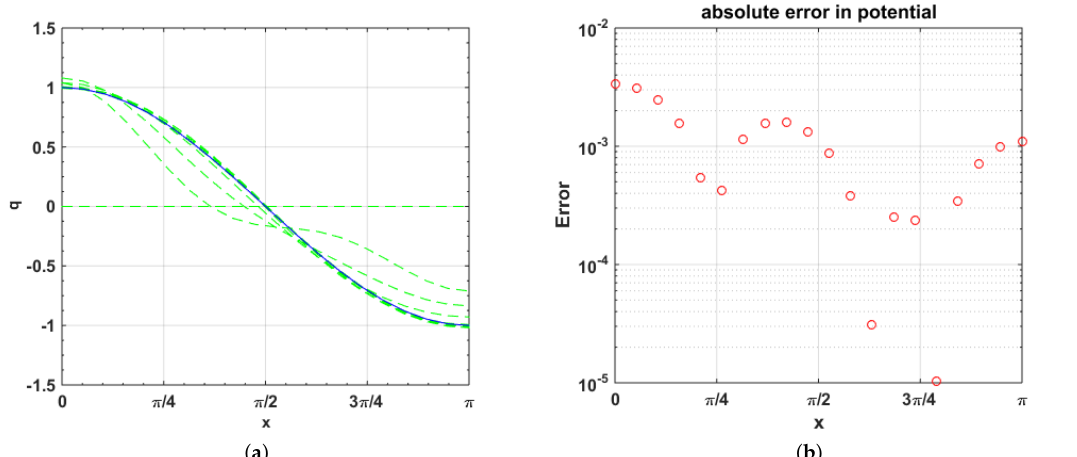
Figure 1. ( a ) Iteratively reconstructed potential (green dashed line) and exact potential (blue solid line) p ( x ) = cos ( x ) ( b ) Log absolute error in the reconstructed p